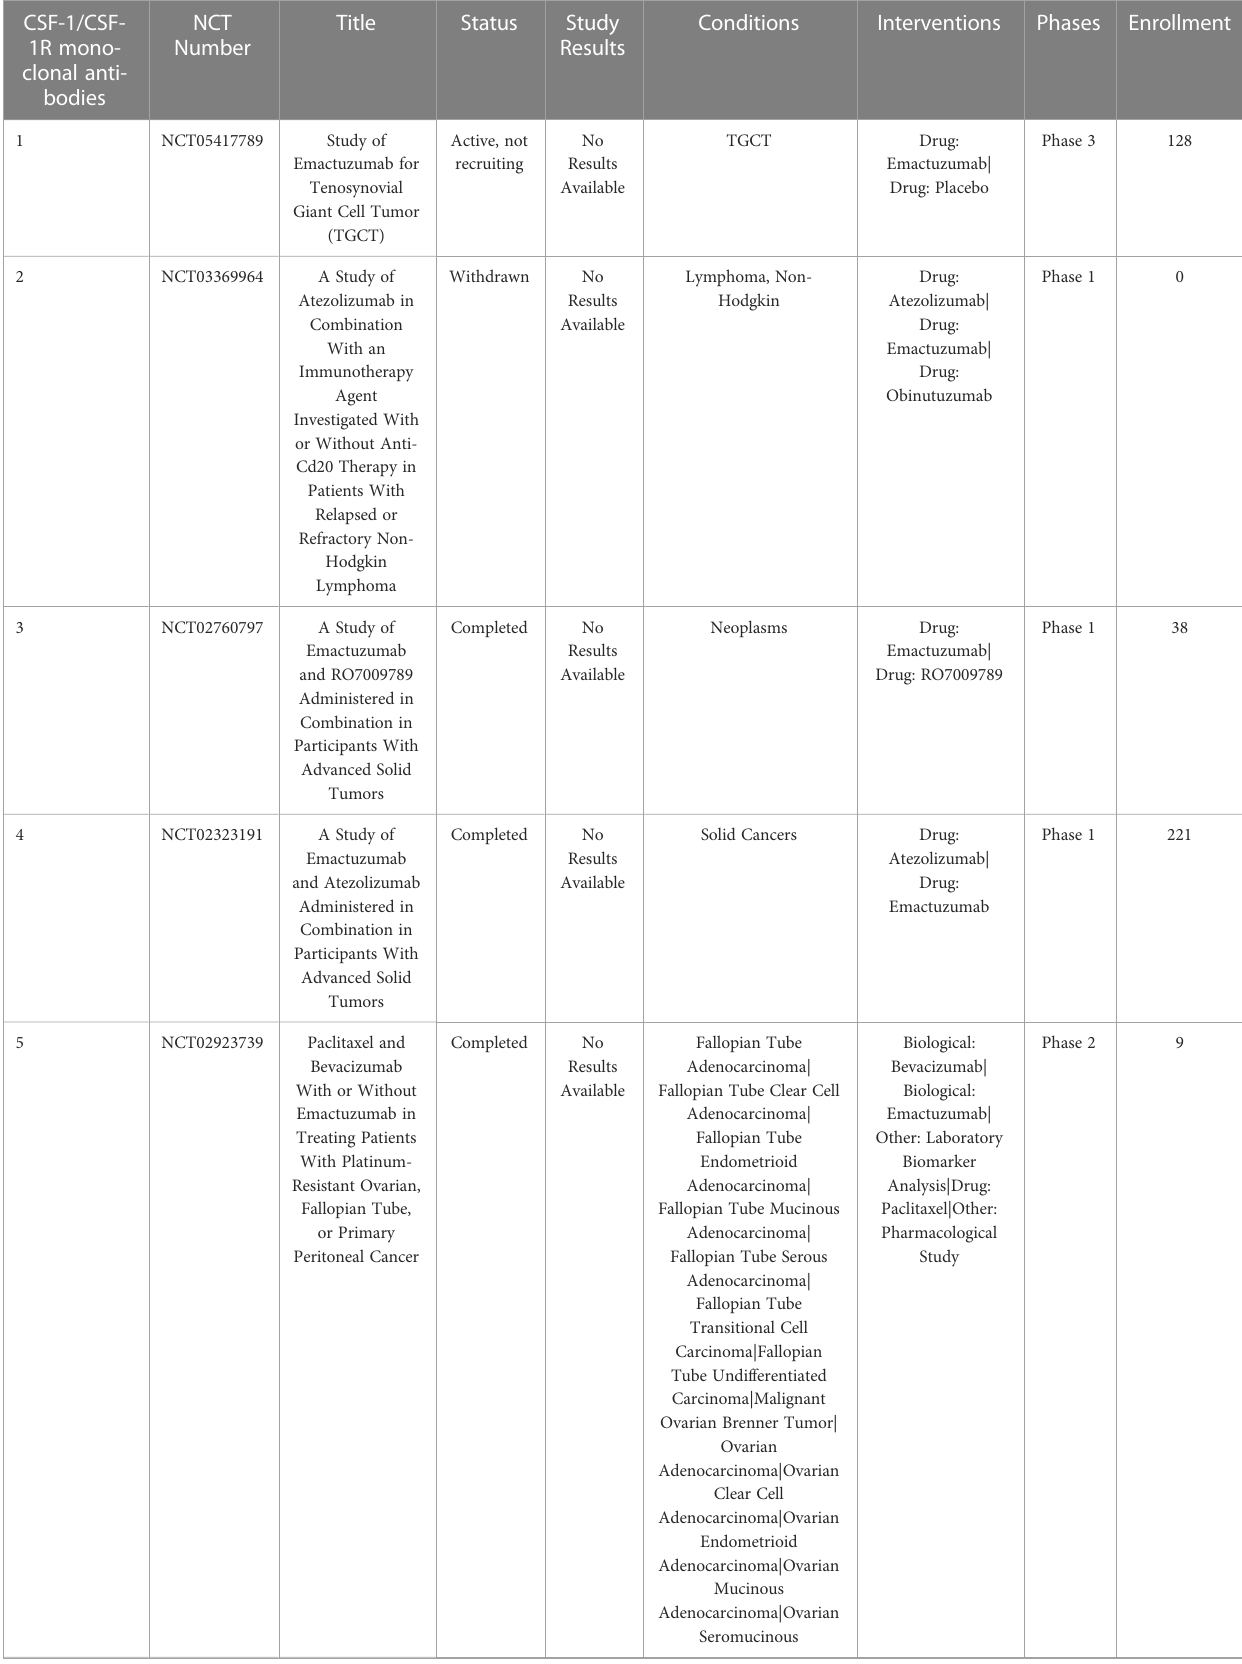
TABLE 2 US clinical trials in cancer using Monoclonal antibodies targeting CSF-1 or CDF-1R. CSF-1/CSF- 1R mono- clonal anti-